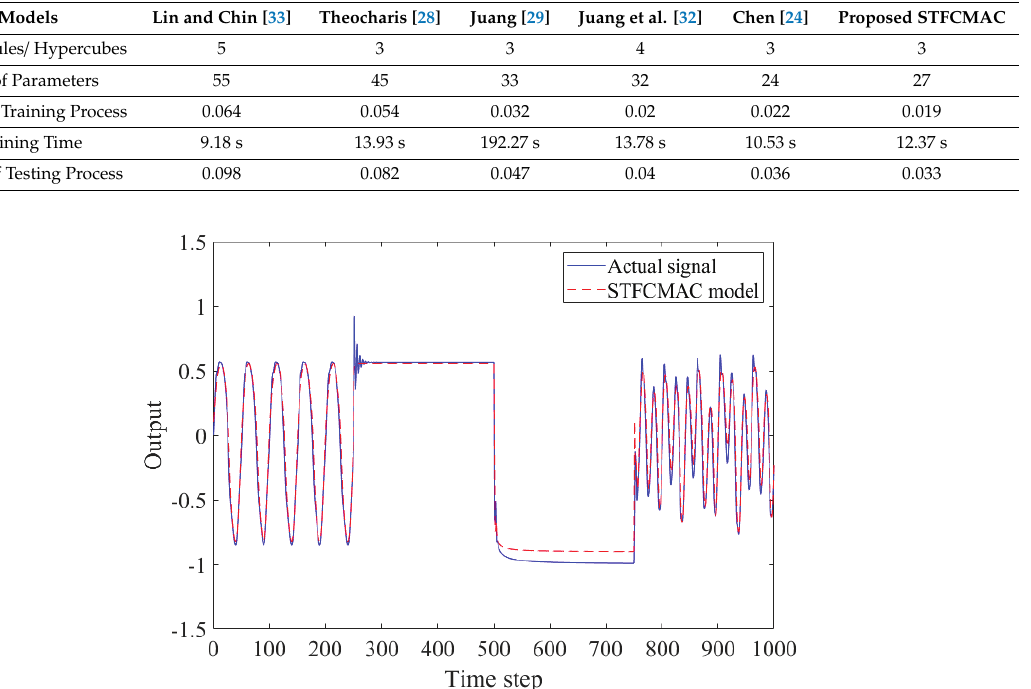
Electronics 2020 , 9 , 631 Figure 4. The results for the identification of a dynamic system obtained using the STFCMAC model.